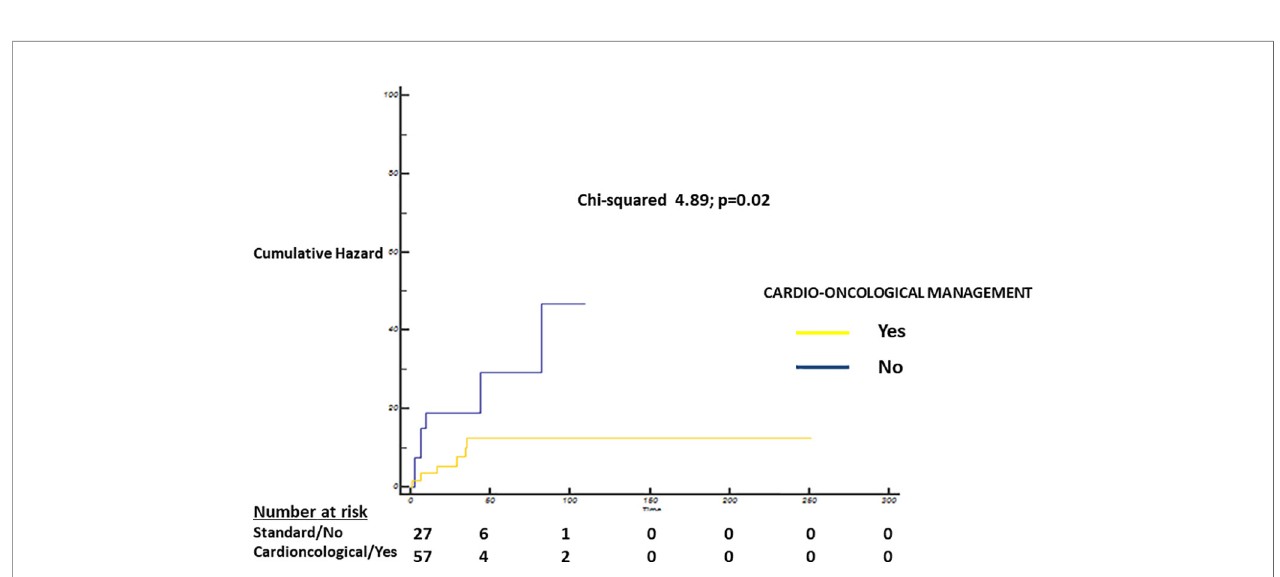
FIGURE 3 | Cumulative Hazard — Log-Rank test showing a statistically signi fi cant difference between patients with standard care (blue) and intensive cardioncological (yellow) management strategy (standard care strategy 78.4, 95% CI 59 – 97 months vs. 98, 95% CI 89.7 – 106.2 months; Chi-squared 4.89; p=0.02).